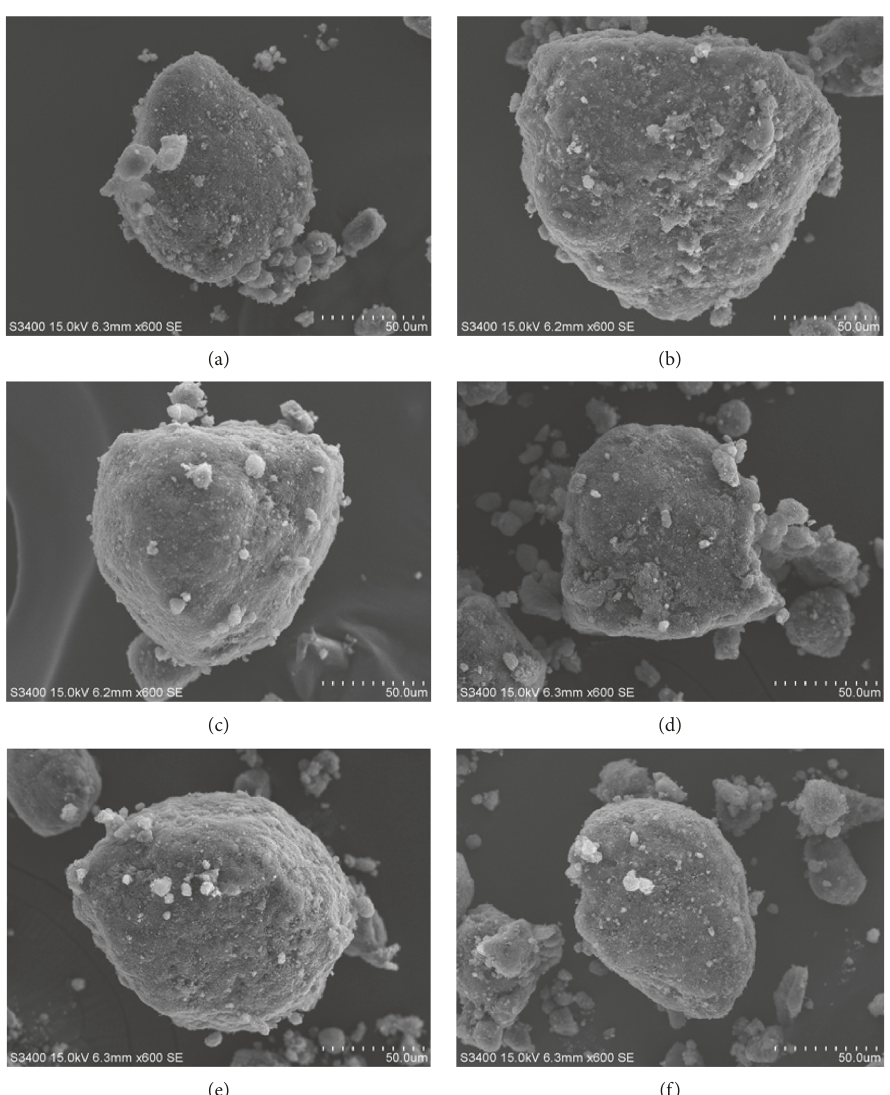
Figure 3: SEM micrographs of the catalysts: (a) AC_H420, (b) AC_H520, (c) AC_H620, (d) AC_N420, (e) AC_N520, and (f) AC_N620.